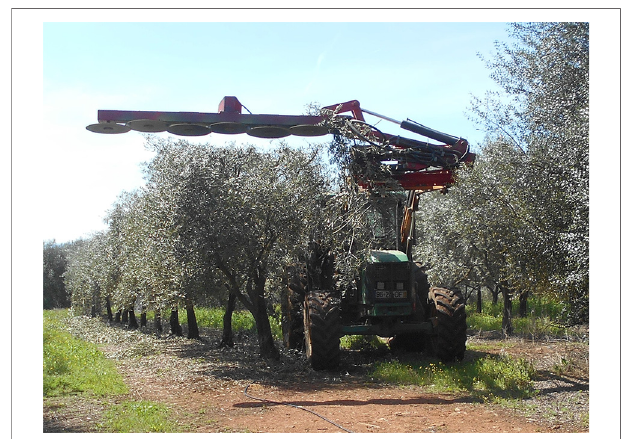
FIGURE 1 | Pruning machine mounted in a